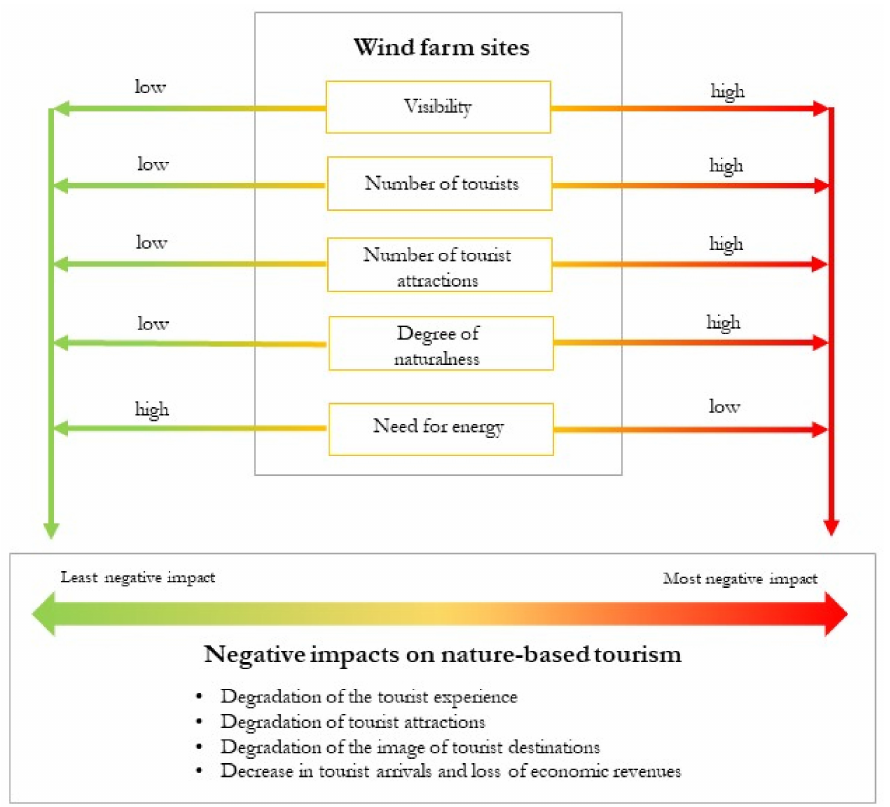
Figure 3. Factors affecting the severity of negative impacts of wind farms on nature-based tourism as perceived by the tourism